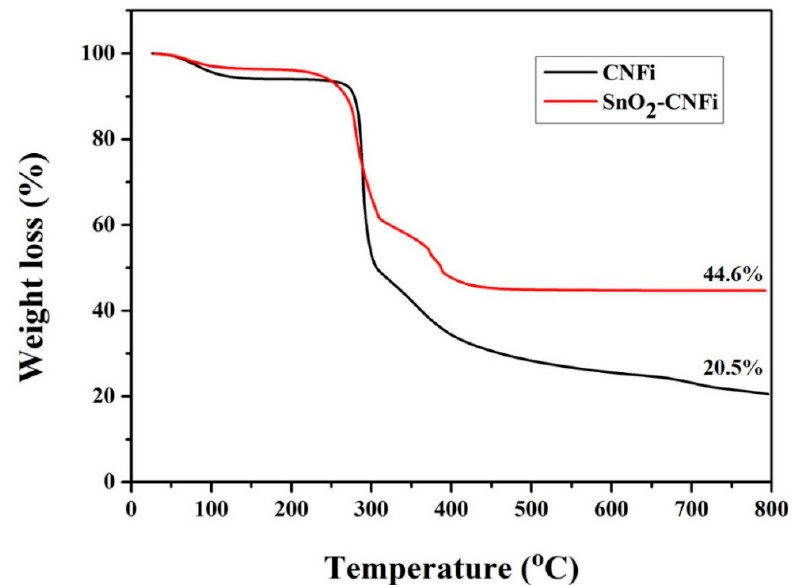
Figure 2. TGA curves of CNFi and SnO 2 -CNFi nanocomposite.